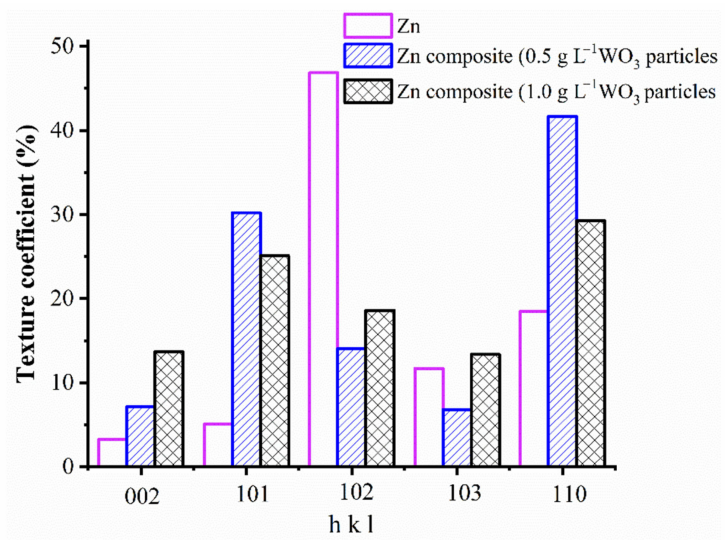
Figure 6. Texture coefficient of Zn and Zn–WO 3 composite